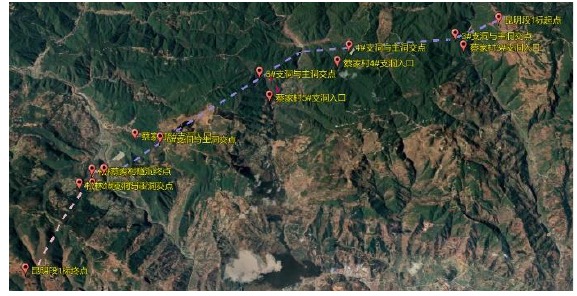
Figure 5. Kunming section construction bid I